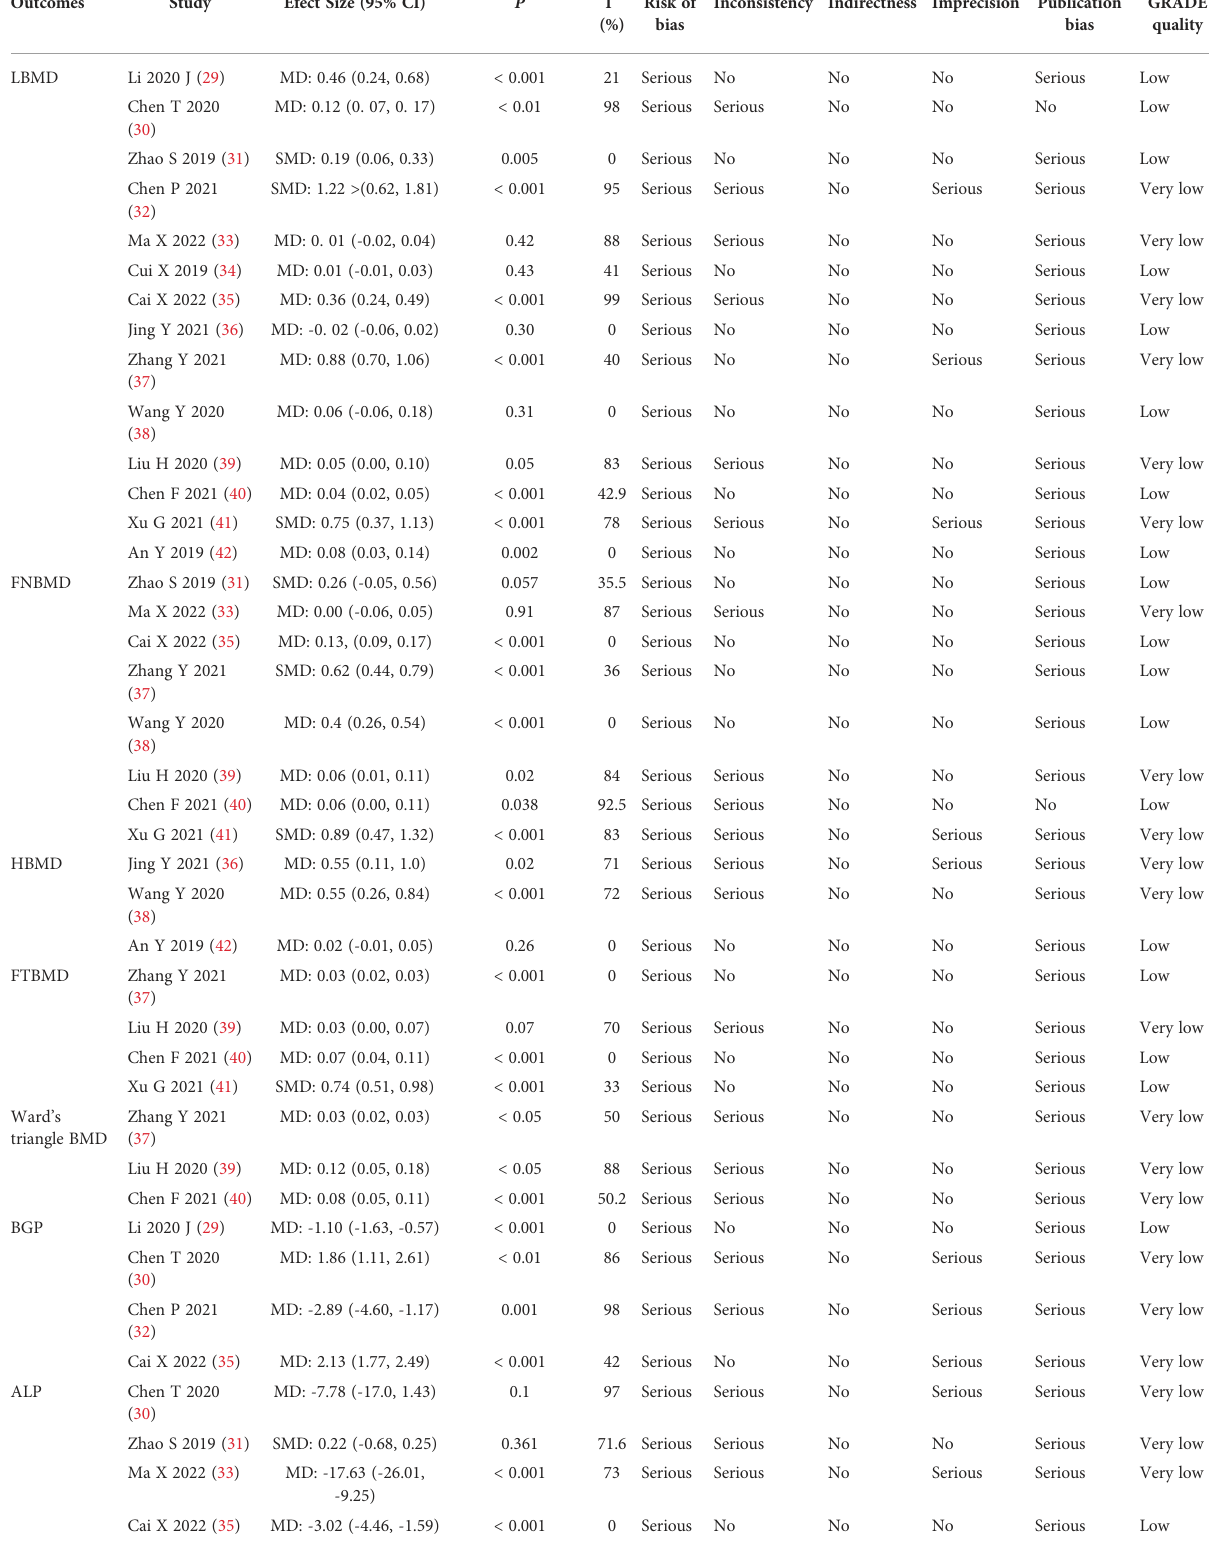
TABLE 3 GRADE grading results of the included systematic reviews or meta-analysis. Outcomes